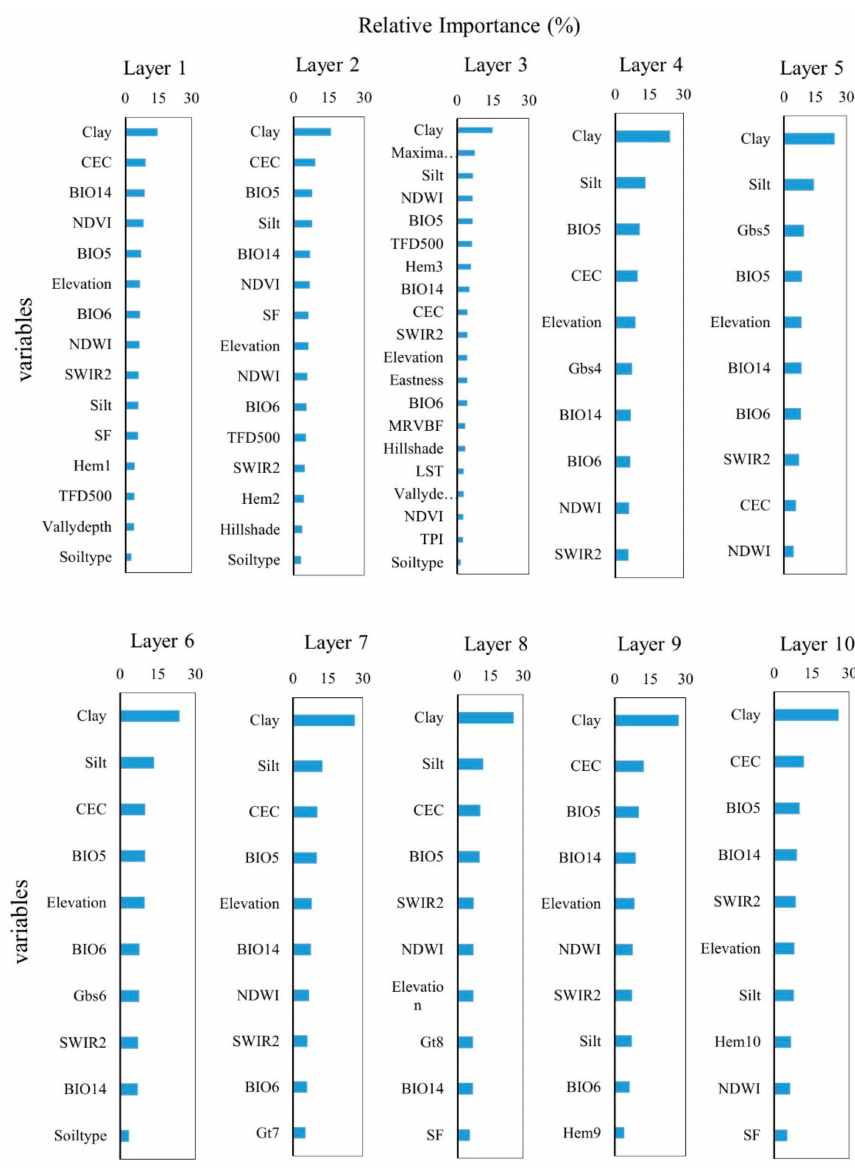
Figure 6. Variable importance for SOC stocks prediction in different depth at Ag = 100 class by RF